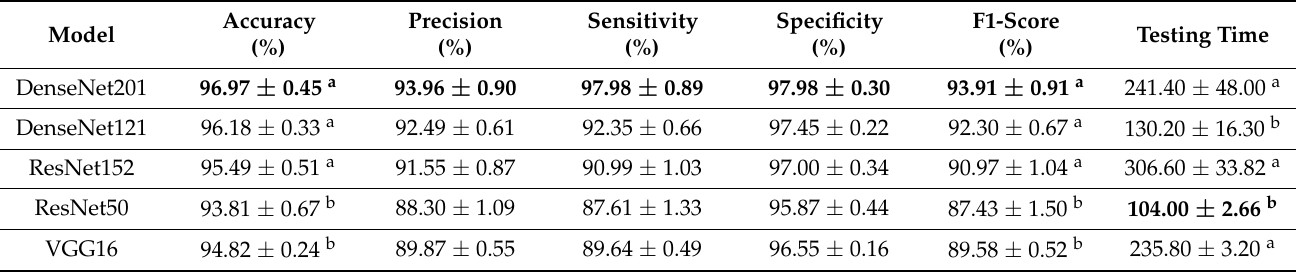
Table 5. Performance of each pre-trained model using SGD optimizer.